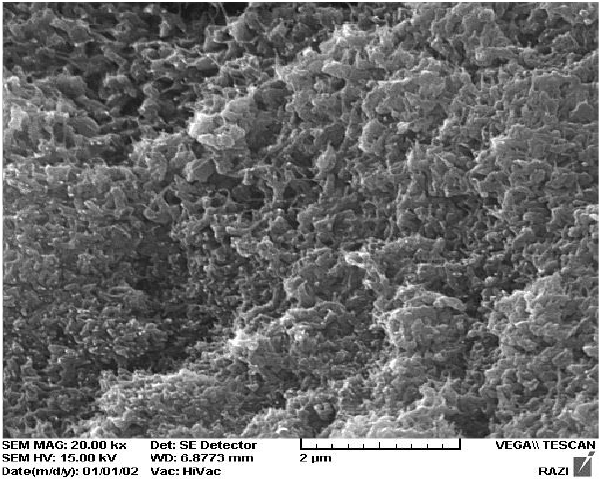
Fig. 2. Scanning electron micrograph of PAn/PVP in aqueous me-